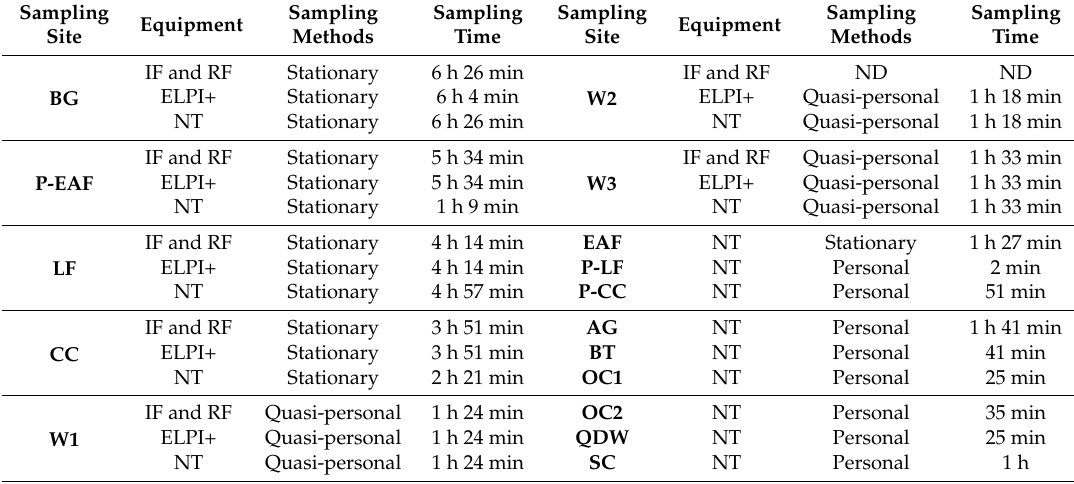
Table 1. Summary of sampling methods carried out in steelmaking